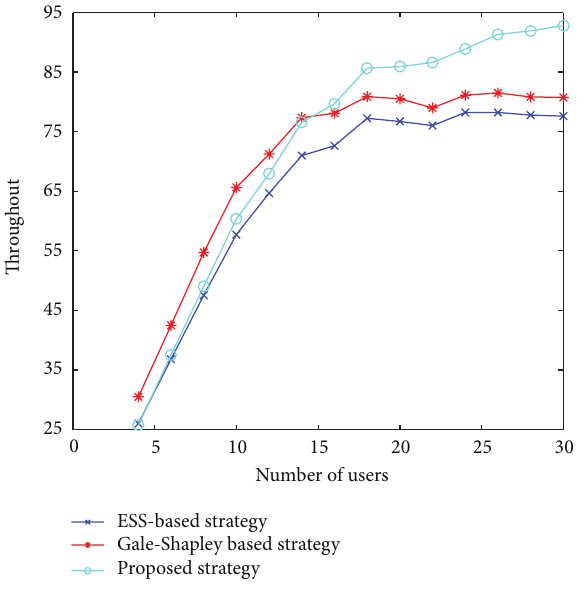
Figure 4: Comparison of channel